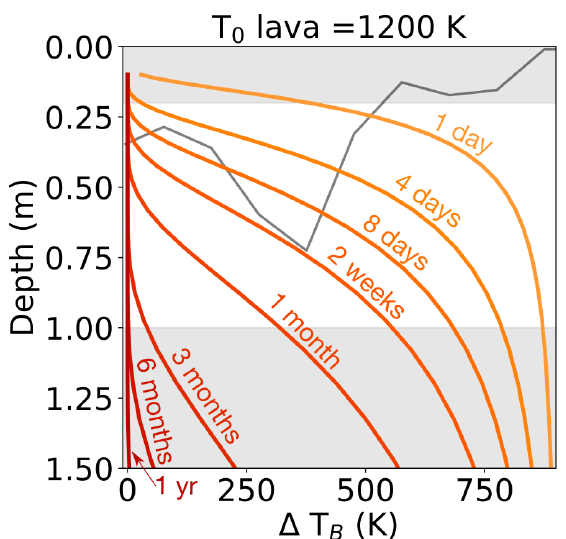
Figure 6. Temperature profile of a basalt flow as a function of depth for different flow ages. Observability of a flow is a confluence of the depths to which SMAP is sensitive (a few wavelengths; white box), the age of the flow (reds), and absorptivity of the flow (approximated by the gray line from the 2.45 Hz measurements of Hartlieb et al.